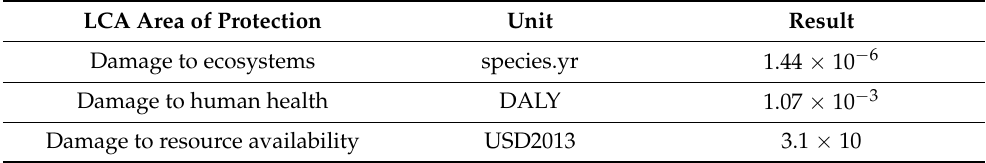
Table 7. Weighted endpoint results and single score, based on the